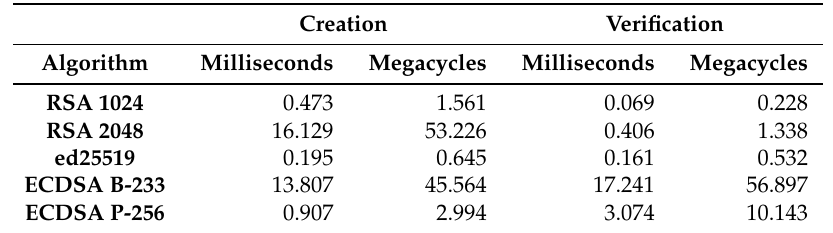
Table 3. Crypto++ signature performance, for both creation and verification, on an AMD Opteron Processor 4238 3.3 GHz